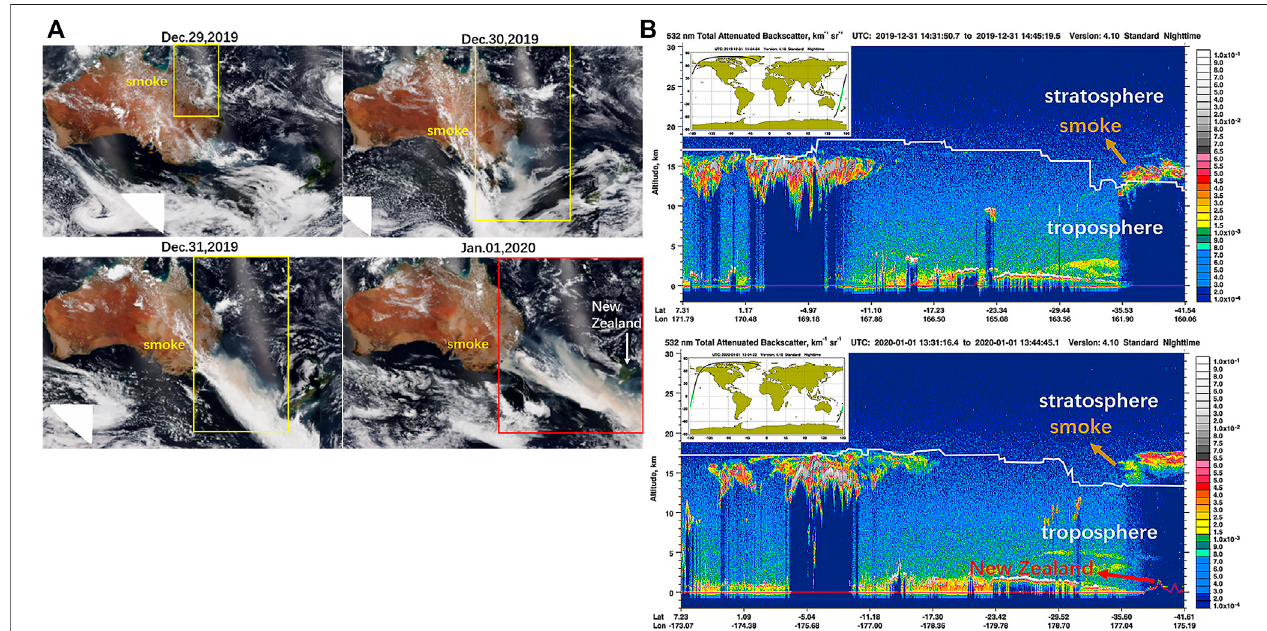
FIGURE1|(A) SuomiNPPVIIRStrue-colourimageryfromDecember29,2019,toJanuary1,2020(background)revealingthetrajectoryofsmoke,withtheyellow boxshowingthetransportofthesmokeplumeovertheTasmanianSea. (B) DatafromtheCALIOPlidarinstrumentshowingtheheight,locationanddensityofthesmoke plume as it moved towards and over New Zealand on December 31, 2019, and January 1,